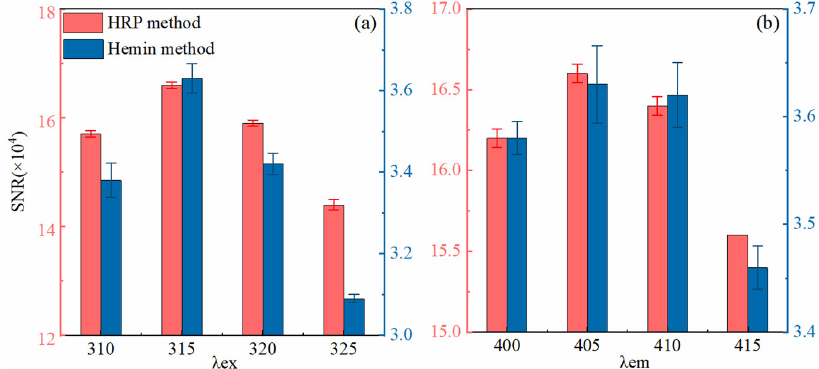
Figure 4. The results of two methods under different ( a ) λex and ( b ) λem.